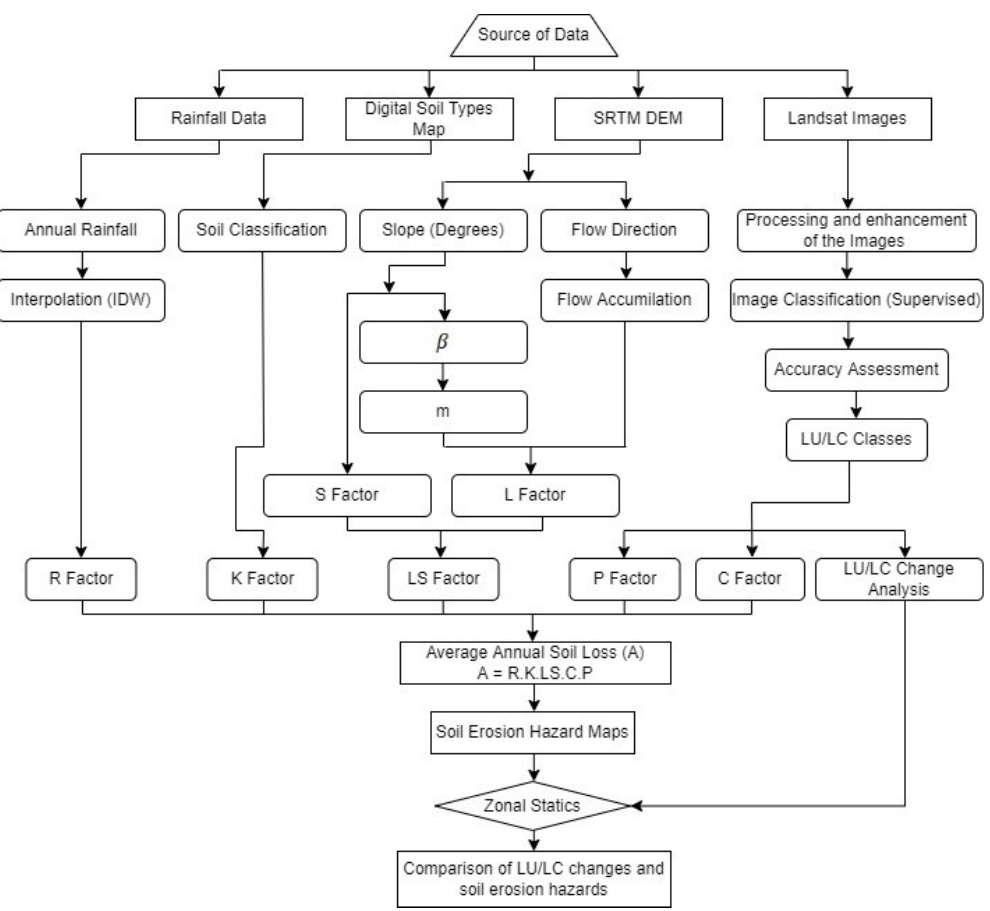
Figure 5. Overall methodology of the research.